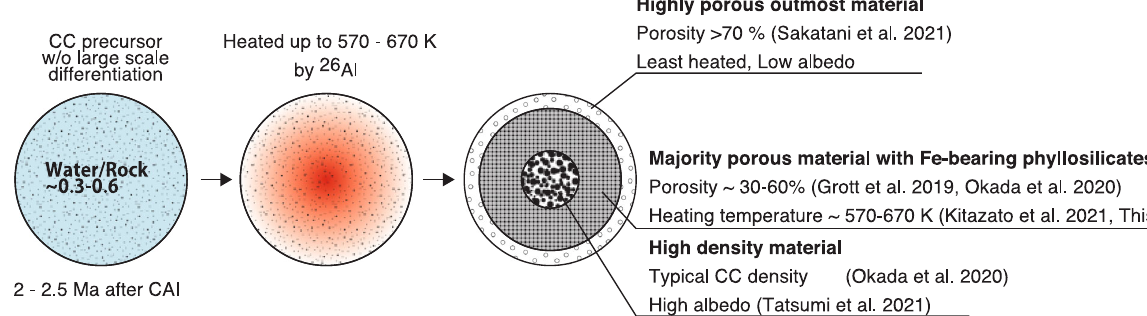
Fig. 8 Hydrothermal history of Ryugu ’ s parent body. (Left) The parent body might consist of similar water/rock ratio to CM chondrites, but accreted with earlier timing, 2 – 2.5 Ma after CAI, to achieve the thermal metamorphism. (Middle) After pervasive aqueous alteration to form a CM-like precursor which included large amounts of Fe-bearing phyllosilicates, the parent body was dehydrated at 570 – 670 K (300 – 400 °C) due to heating by radioactive decay of short-lived radionuclides (e.g., 26 Al). (Right) Ultimately, Ryugu ’ s parent body consisted of several layers with different degrees of thermal metamorphism. Different evidence were discovered in the previous studies 5,15,41,56 .